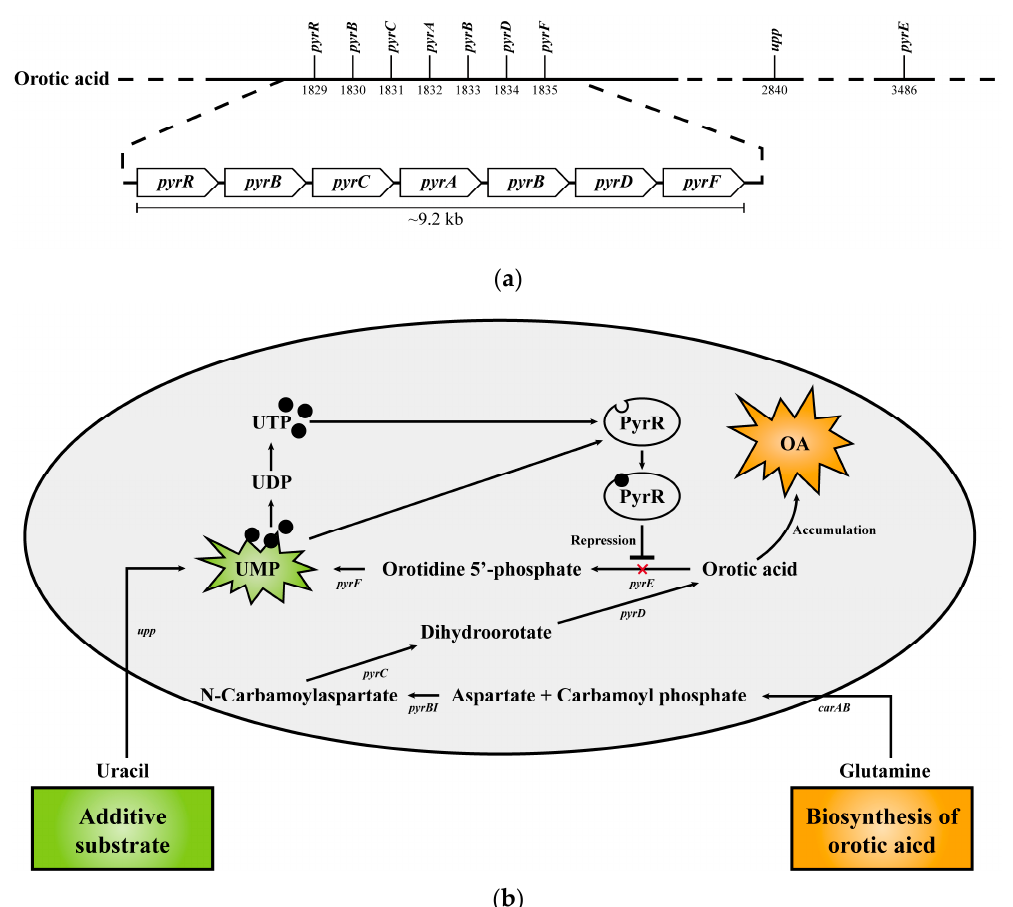
Figure 8. Biosynthetic pathway of orotic acid in E. keratini EPI-7 T . ( a ) The gene cluster for biosynthesis of orotic acid shows the distribution in the E. keratini EPI-7 T genome. ( b ) The names of genes encoding enzymes used in each step of orotic acid biosynthesis and UMP synthesis are as follows: carAB, carbamoyl-phosphate synthase small chain/carbamoyl-phosphate synthase large chain; pyr BI, aspartate carbamoyltransferase catalytic subunit/aspartate carbamoyltransferase regulatory chain; pyr C, dihydroorotase; pyr D, dihydroorotate dehydrogenase; pyr E, orotate phophoribosyltransferase; pyr F, orotidine-5 ′ -phosphate decarboxylase; pyr R, bifunctional pyr operon transcriptional regulator/uracil phosphoribosyltransferase Pyr R; upp , uracil phosphoribosyltransferase.